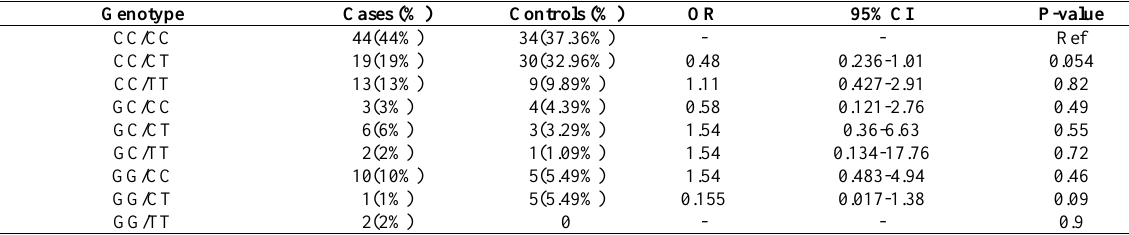
Table 5 . Association of different genotypic combinations of IL-33 gene and